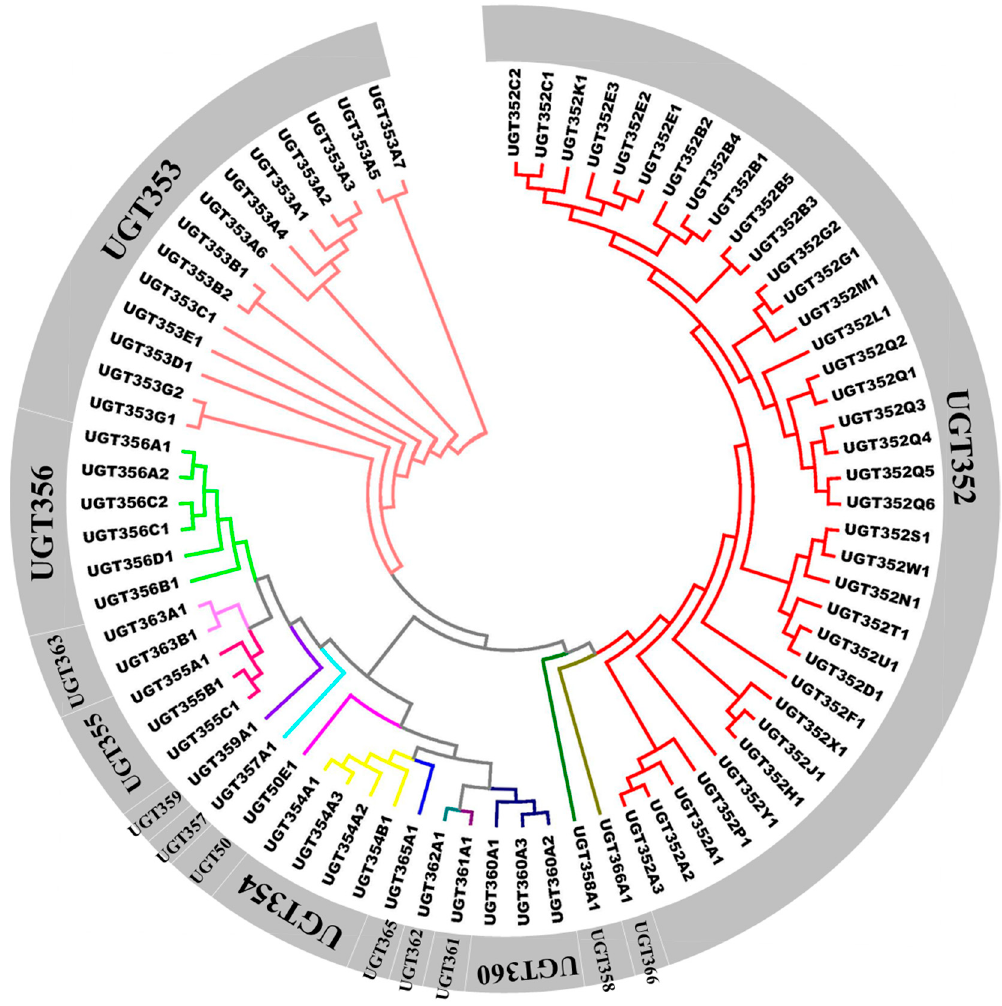
Figure 2. Phylogenetic relationships among the 76 UDP-glucuronosyltransferases (UGTs) in B. tabaci MEAM1. Amino acid sequences were aligned using ClustalW and subjected to a Neighbor-Joining (NJ) analysis by MEGA6 [42].